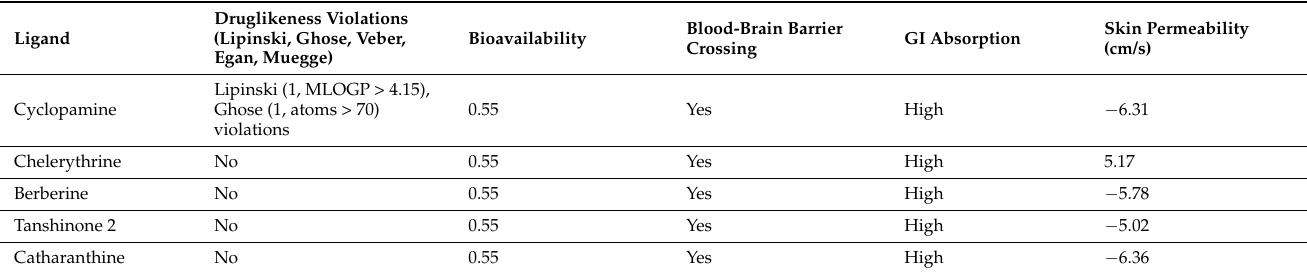
Table 4. Pharmacokinetic properties of top